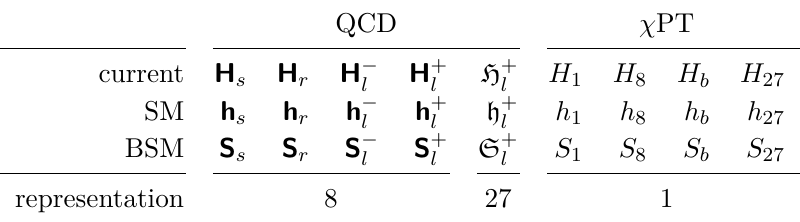
Table 10. Currents that couple to the QCD four-quark operators introduced in section 2.3 and the derived parameters we use in χ PT, cf. equations eq. (4.41), Lagrangian (4.44), and (4.46). The table indicates the names for the SM and BSM contributions, as well as their representations under G LR